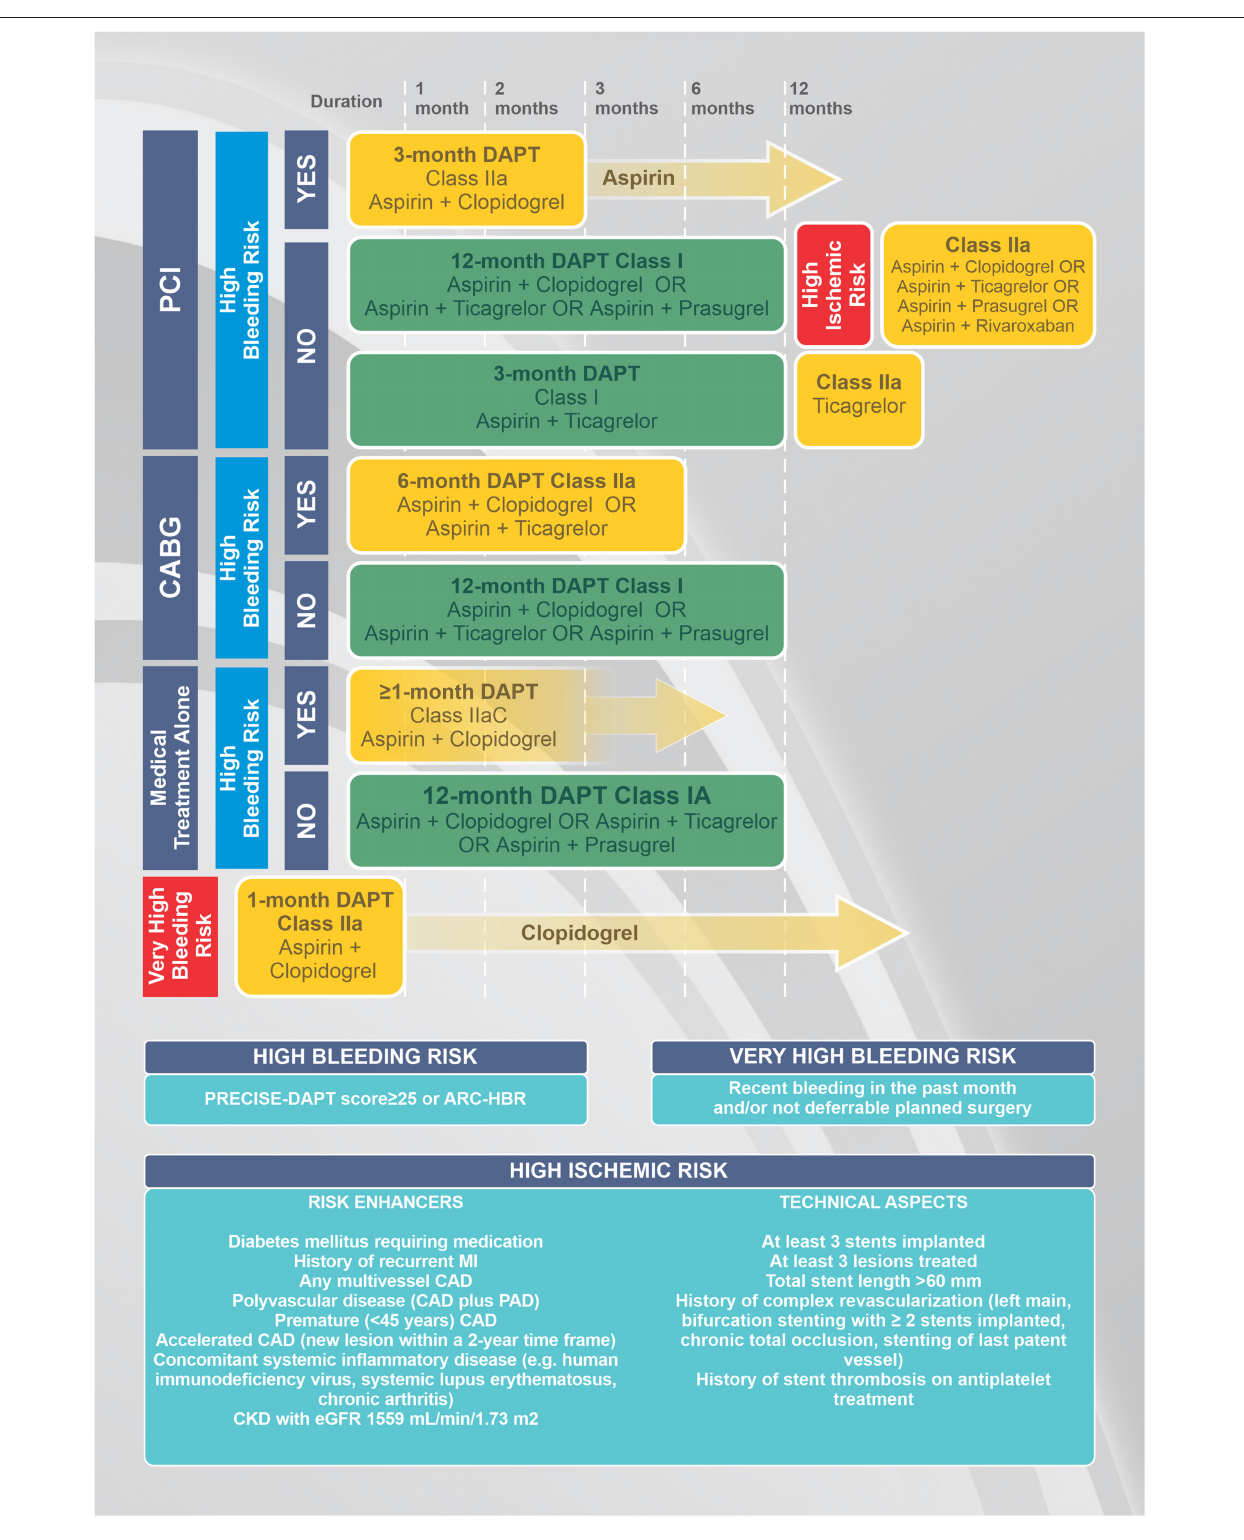
Frontiers in Cardiovascular Medicine |